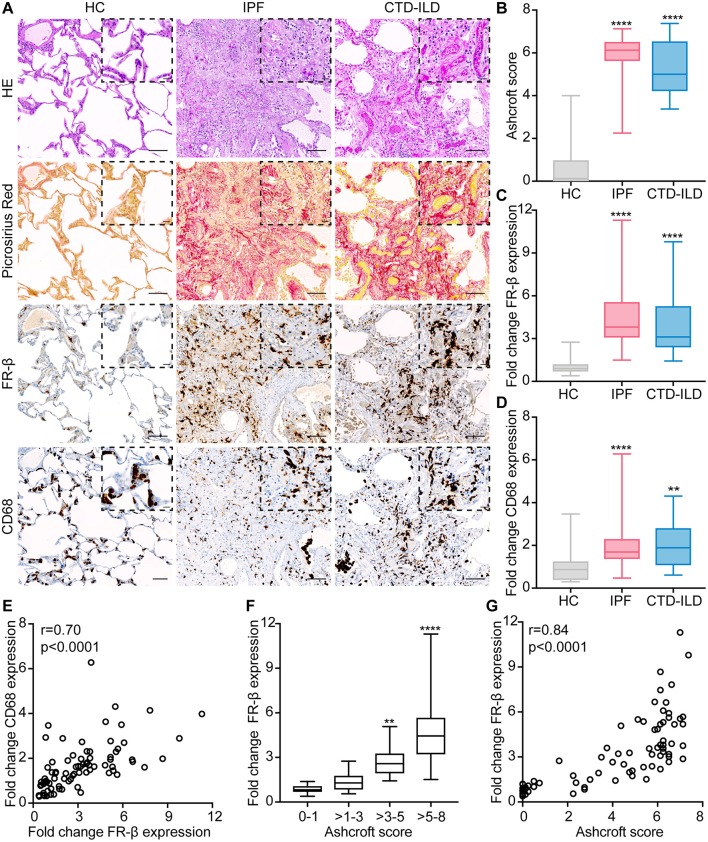
FR-β expression is increased in human ILD and correlates with the severity of lung remodeling. (A) Representative images of lung sections from healthy controls (HC) and patients with IPF and CTD-ILD stained with hematoxylin and eosin (HE, first panel), Picrosirius Red (collagen = red, second panel), FR-β (brown, third panel) and CD68 (brown, fourth panel). Representative pictures at 100× magnification (scale bars: 100 μm) and at higher magnification (400×, scale bars: 20 μm) are shown. (B) Semi-quantification of pulmonary fibrosis by Ashcroft score. (C) Semi-quantification of FR-β tissue expression by automatic image analysis. (D) Semi-quantification of CD68 tissue expression by automatic image analysis. (E) Spearman correlation of FR-β expression with the CD68 expression. (F) Analysis of FR-β expression according to the severity of lung remodeling as defined by the Ashcroft score (score 0–1: no fibrosis, scores >1–3: mild fibrosis, scores >3–5: moderate fibrosis, scores >5–8: severe fibrosis). (G) Spearman correlation of FR-β expression with the Ashcroft score. For (B–D,F) data are displayed as box plots with min/max values. For statistical analysis, the Kruskal–Wallis test with Dunn's multiple correction was applied (*p < 0.05, **p < 0.01, ***p < 0.001, ****p < 0.0001). For all experiments: n = 26 for healthy controls, n = 39 for IPF patients, and n = 14 for CTD-ILD patients.